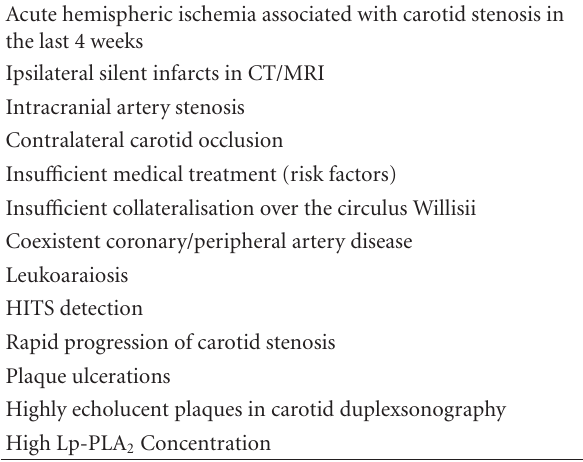
Table 3: Factors that increase stroke risk in patients with carotid